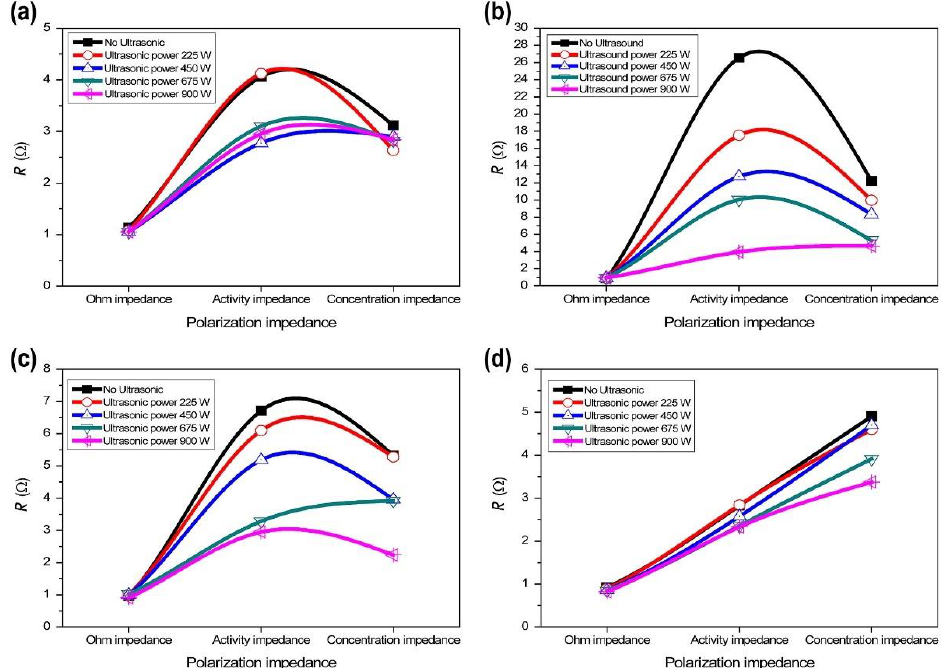
Figure 5. Polarization impedance of different electrolyte concentrations with a 2 V cell voltage and electrode distance of 2 mm. ( a ) 10 wt%; ( b ) 20 wt%; ( c ) 30 wt%; ( d ) 40 wt% KOH [11].